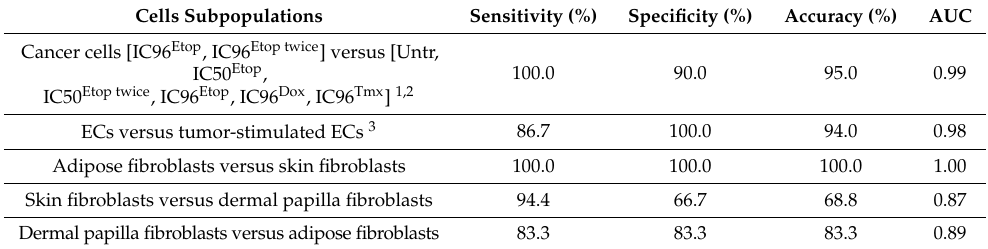
Table 2. The separation efficiency of different cell subpopulations based on CPF. Cells Subpopulations Sensitivity (%) Specificity (%) Accuracy (%)